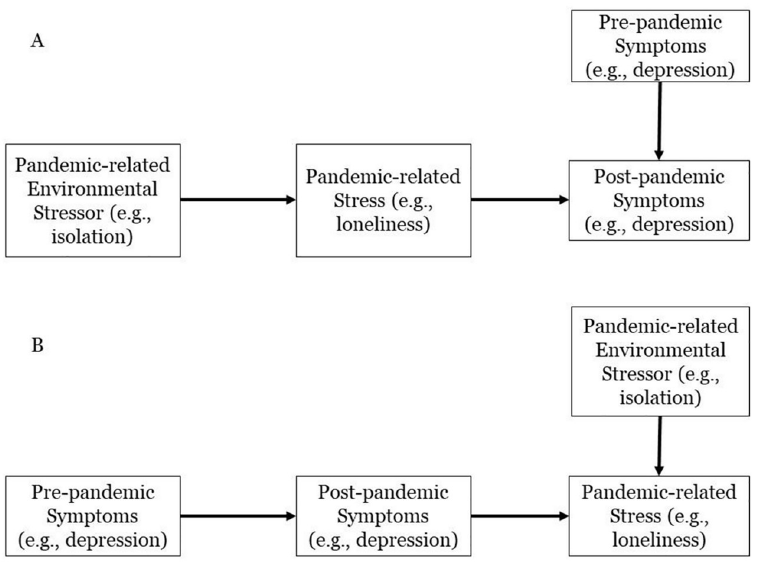
Fig 1. Alternate explanations for the association between COVID-19 pandemic-related stress and mood disorders. Fig 1a presents a general stressor model, where pandemic-related environmental stressors lead to stress, which in turn leads to a change in symptom severity. Fig 1b presents a diathesis-stress model, where pandemic-related stress is predicted by both current levels of symptom severity and pandemic-related environmental